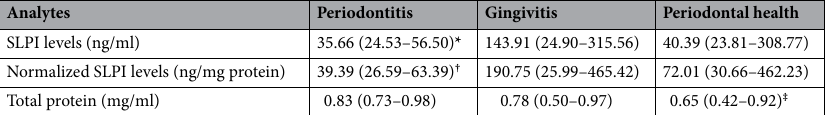
Table 2. Salivary SLPI concentrations and total protein levels of the study groups. Data are expressed as median (minimum–maximum). *Significantly different from gingivitis group (p < 0.05). † Significantly different from gingivitis and periodontally healthy group (p < 0.05). ‡ Significantly different from gingivitis and periodontitis group (p < 0.05). SLPI secretory leukocyte protease inhibitor, ng nanogram, mg milligram, ml